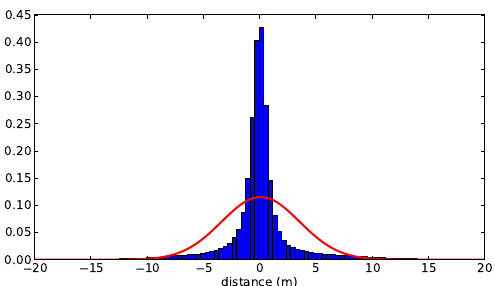
Figure 3: Histogram of errors for Worldview-1 Vacarisses DSM, showing the deviation from the normal distribution. The red curve are the expected counts from a normal distribution with mean and σ estimated from the error distribution with the stan- dard techniques. The mismatch happens due to the heavy tails.